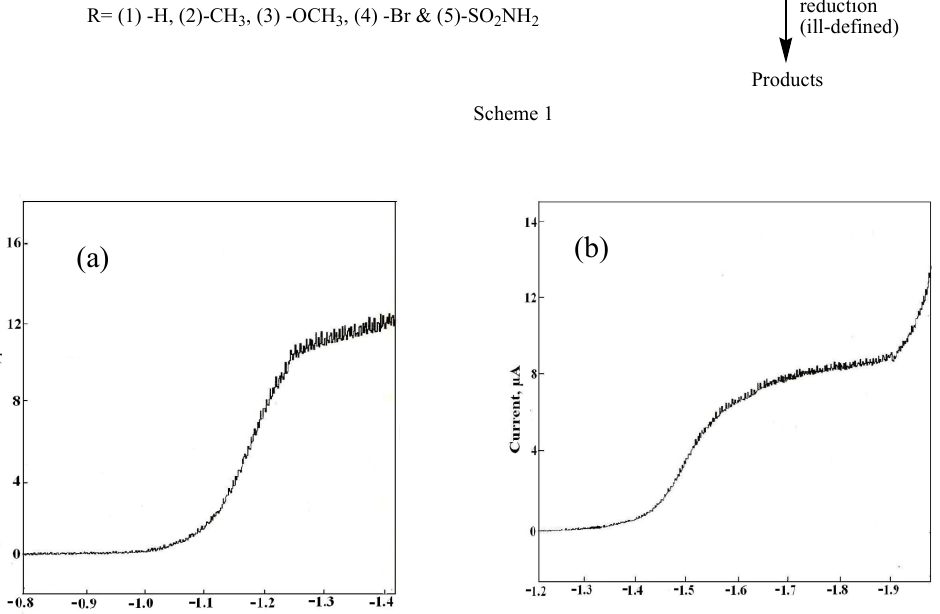
Figure 1: Polarograms of N'-(p-toluenesulphonyl)-3-methyl-4-(arylhydrazono)-2-pyrazolin- 5-one. conc. = 1 mM; Medium = 65% aq. DMF. (a) pH = 4.0; (b) pH =